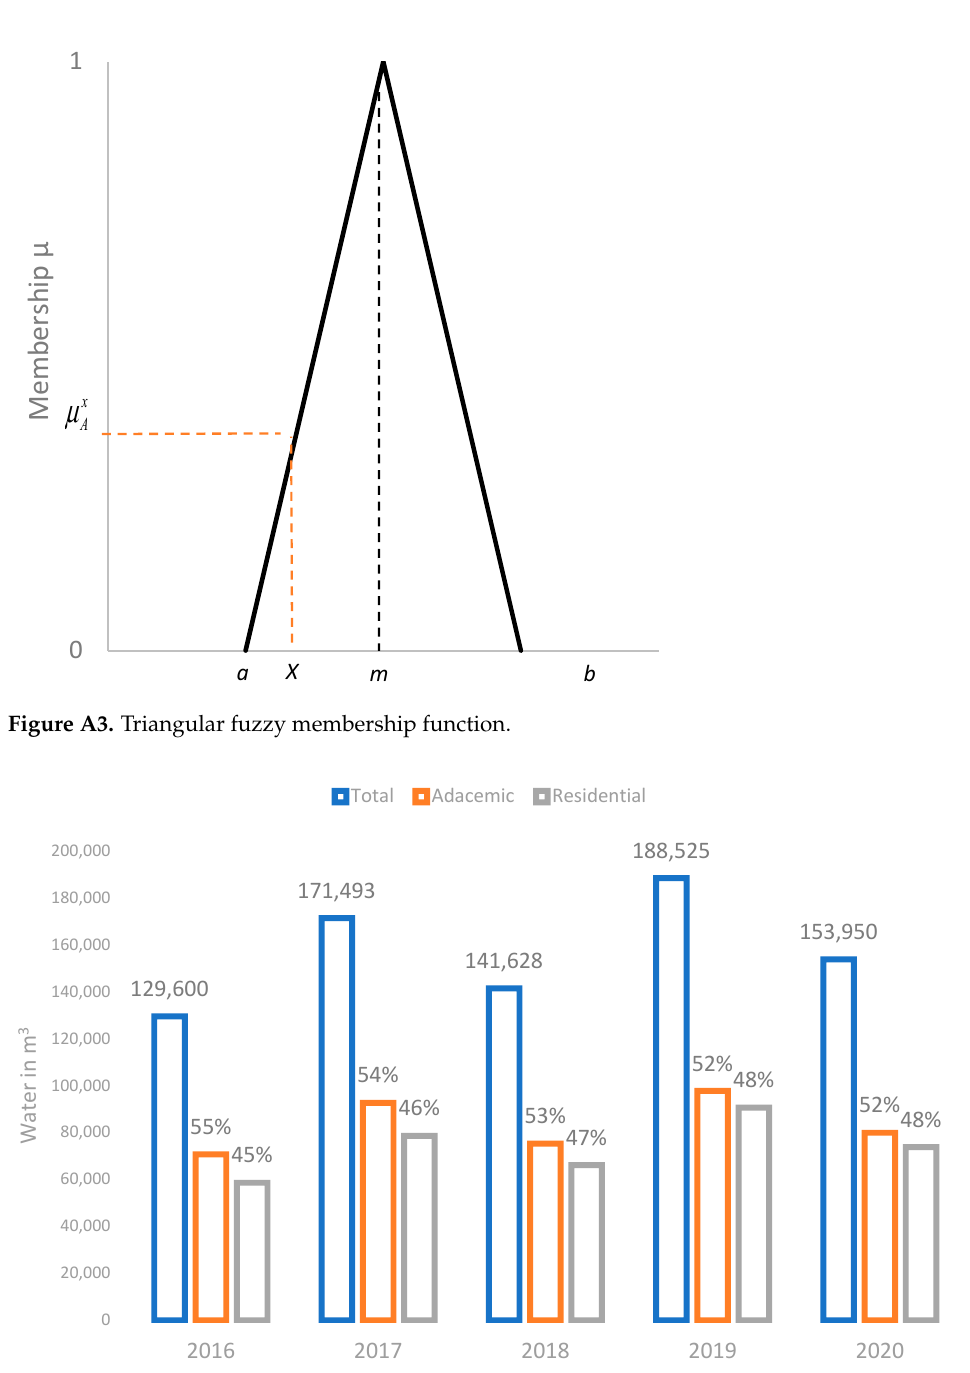
Figure A4. Total campus water consumption.